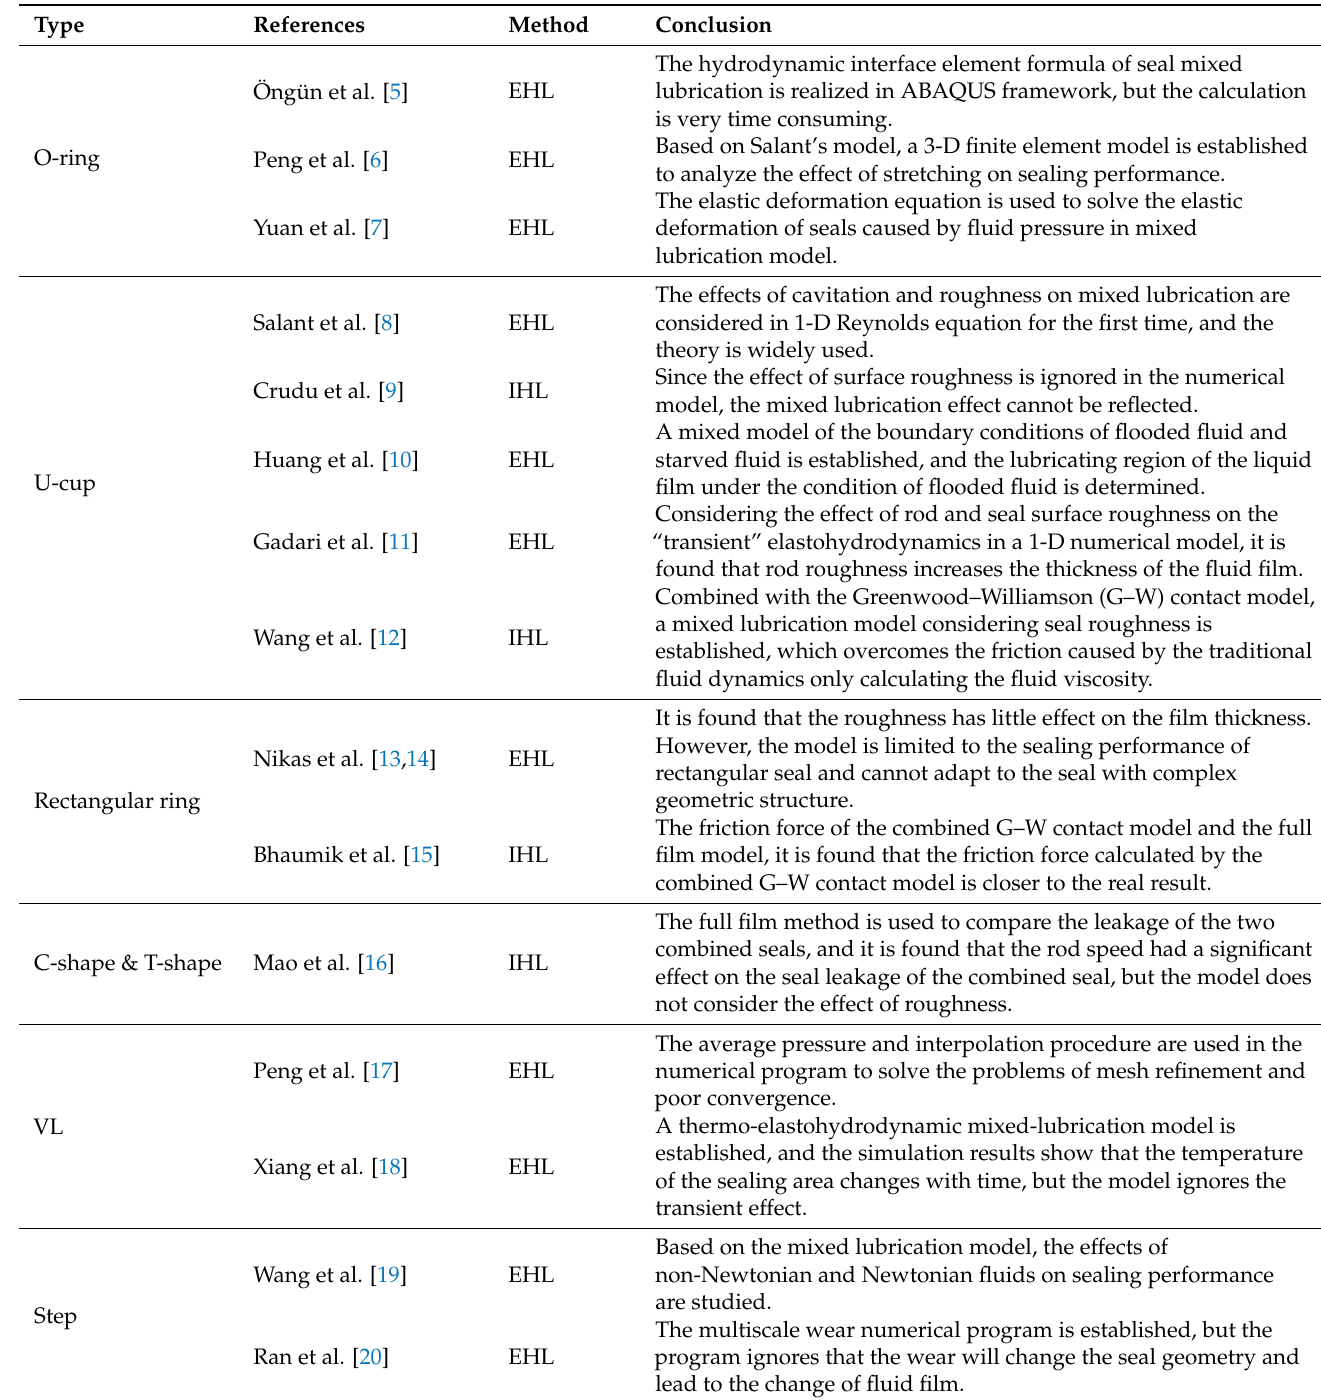
Table 1. Comparison of some typical single seals with combined